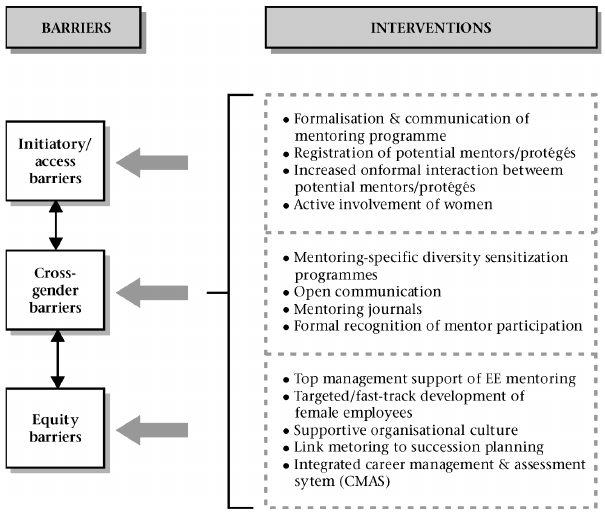
Figure 1 Proposed taxonomy of interventions for